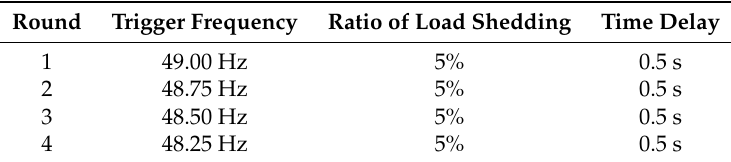
Table 2. Parameters of under-frequency load shedding